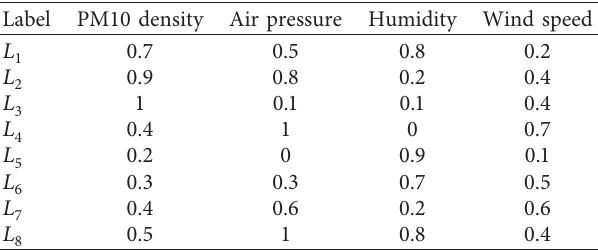
Table 2: Tabular presentation of the fuzzy soft set in Example 2.